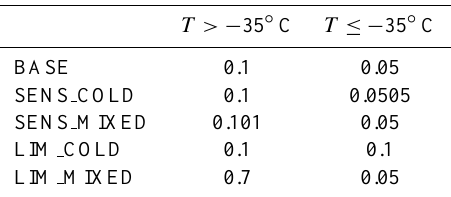
Table 2. Ice nucleation scavenging ratio in the base case and four sensitivity